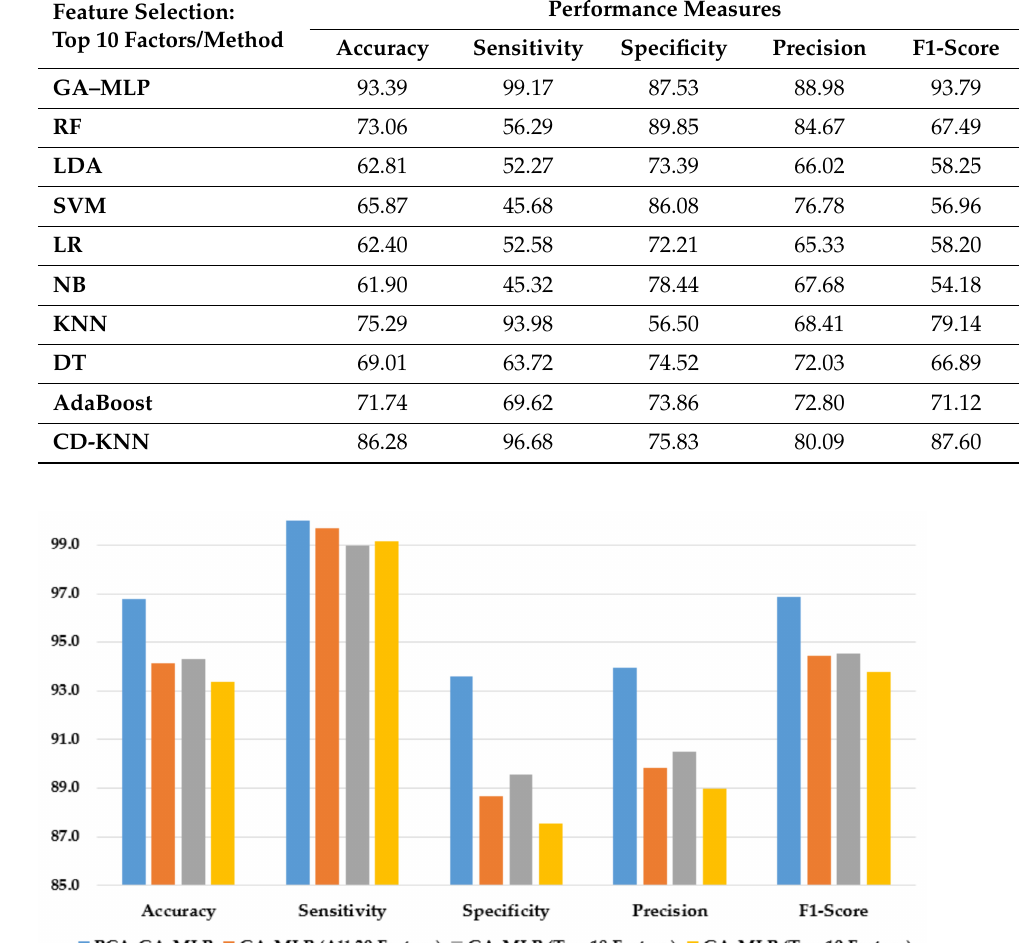
Figure 4. Comparison of the proposed method using four feature selection methods to diag- nose Schiller.